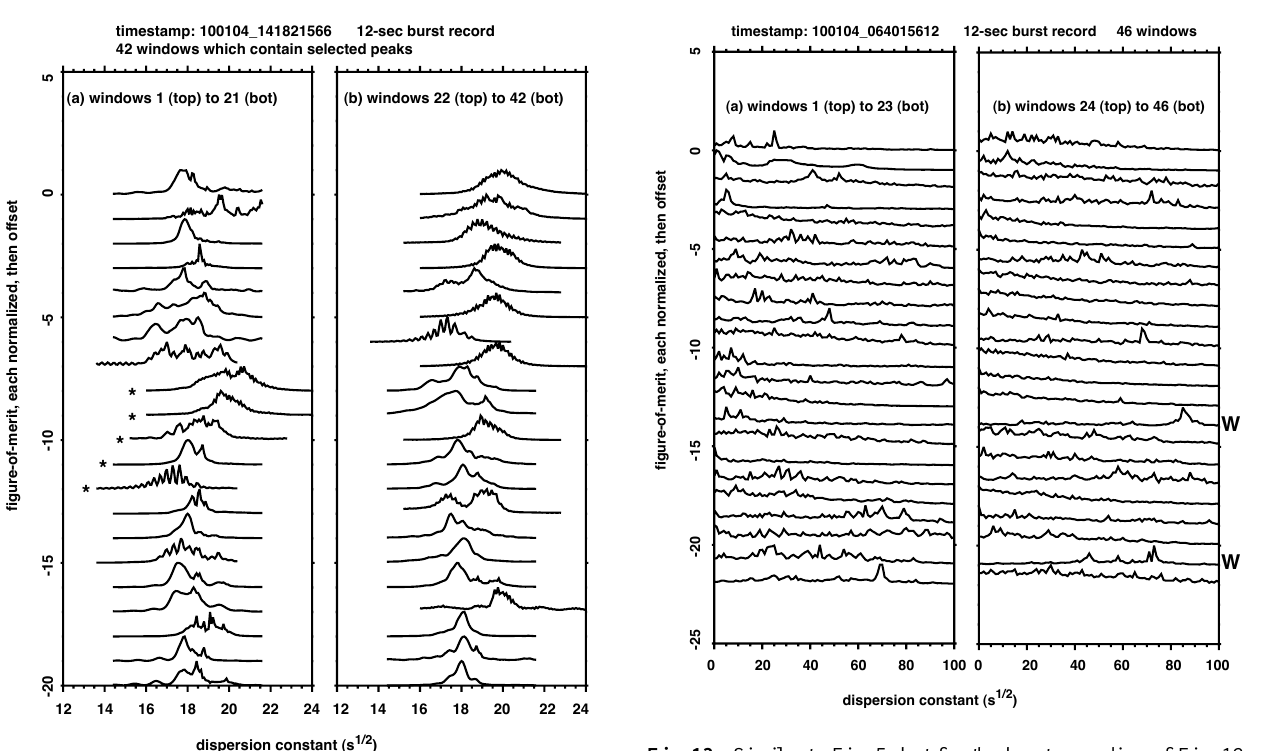
Fig. 13. Similar to Fig. 5, but for the burst recording of Fig. 12. Each of the 46 successive analysis windows fails the